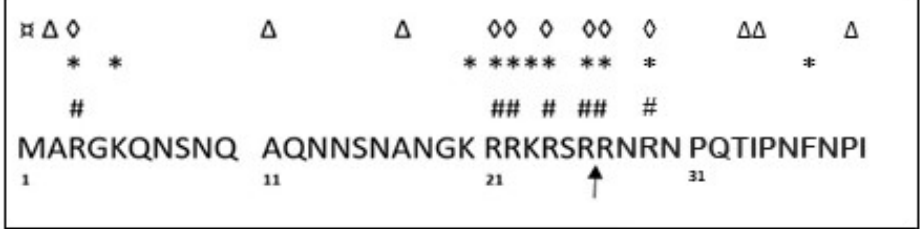
Figure 2. Possible proteolytic cleavage sites of the MrNV CP analyzed using the PeptideCutter program. The MrNV CP proteolytic sites (accession number AHM92901) from amino acid residues 1–27 are shown with the following symbols: (¤): chymotrypsin, ( ∆ ): proteinase K, ( ♦ ): Arginine C proteinase, (#): clostripain and (*): trypsin. The arrow below the amino acid sequence indicates the cleavage site as determined by the Edman degradation sequencing.